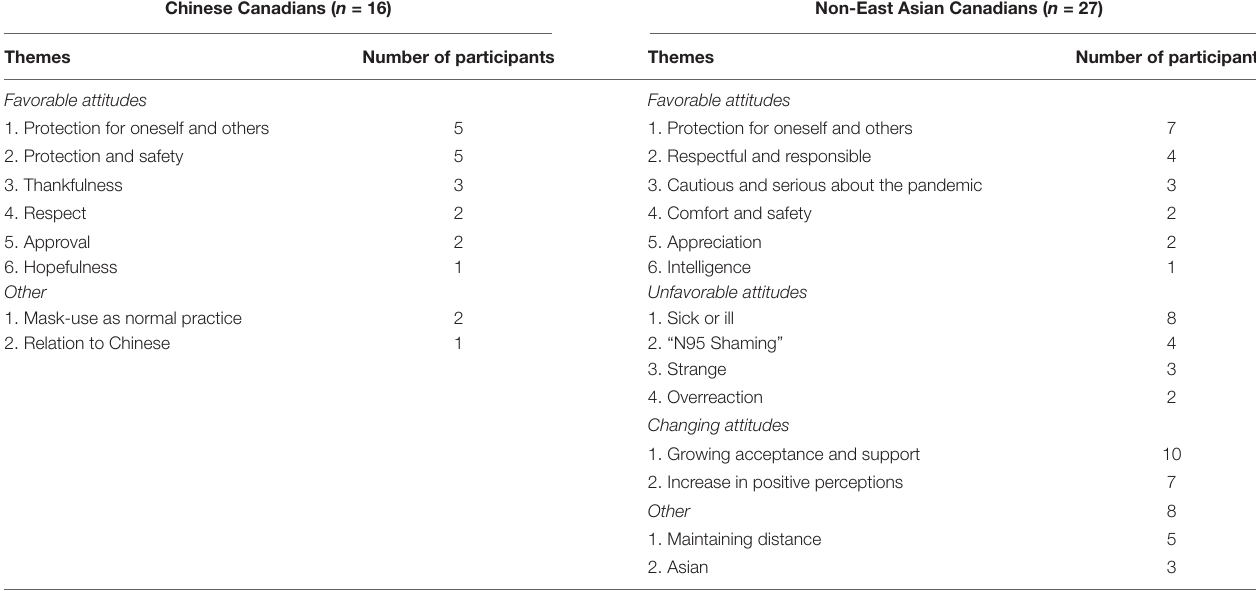
TABLE 1 | Themes in Canadians’ reported attitudes toward mask